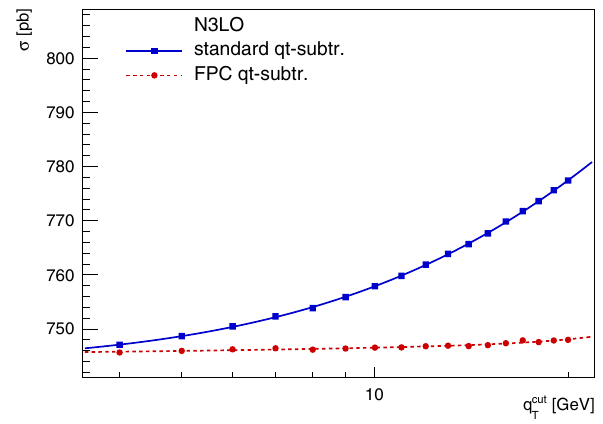
Fig. 3 Fiducial cross section for the production of l + l − pairs from √ Z /γ ∗ decay at the LHC ( s = 13 TeV). NLO results with the q T subtractionmethod(bluesquaredpoints)andthe q T subtractionwithout FPC (red circled points) at various values of q cut T